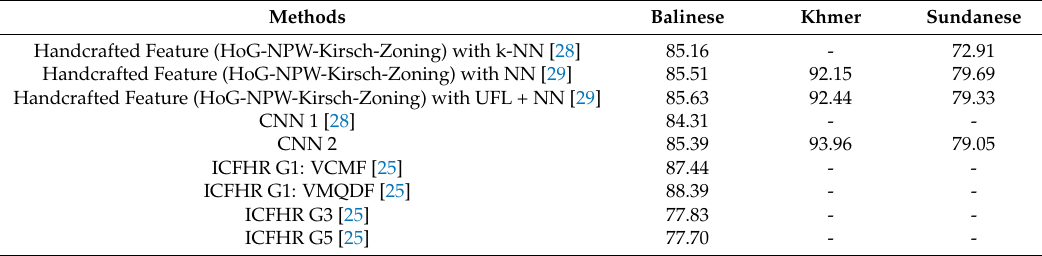
Table 7. Experimental results for isolated character/glyph recognition tasks (in % recognition rate).